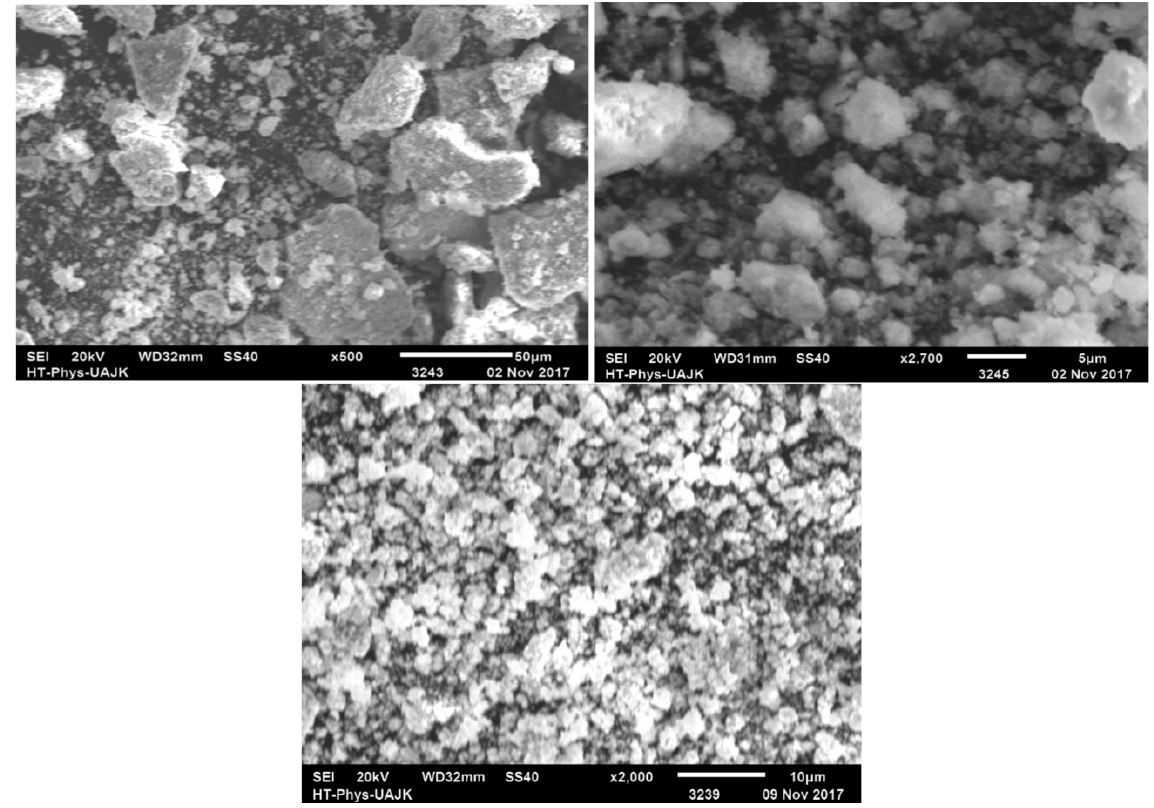
Figure 4. SEM micrographs of biosynthesized